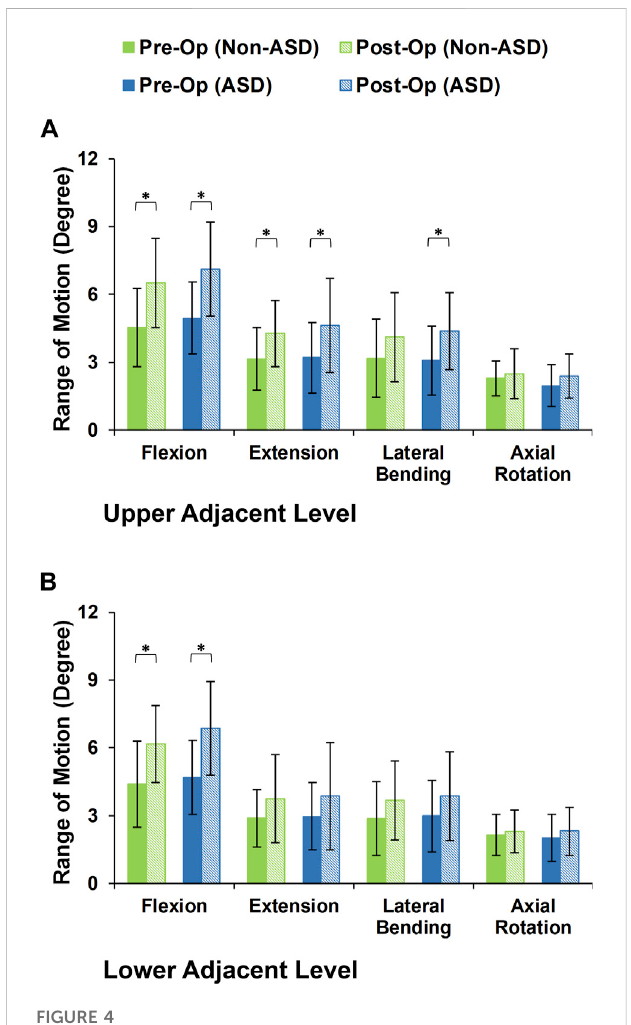
FIGURE 4 Intersegmental motion patterns for non-ASD and ASD group FE models in the (A) upper and (B) lower adjacent level for different directions.